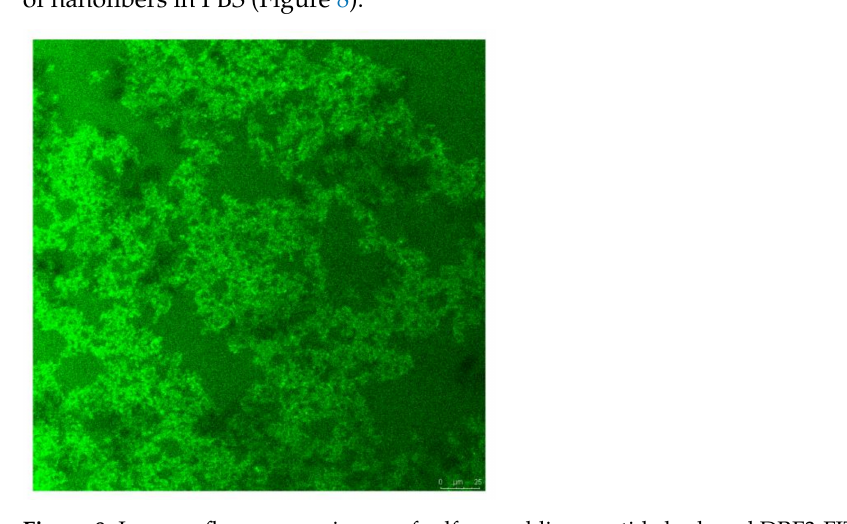
Figure 8. Immunofluorescence image of self-assembling peptide hydrogel DRF3-FITC in PBS.